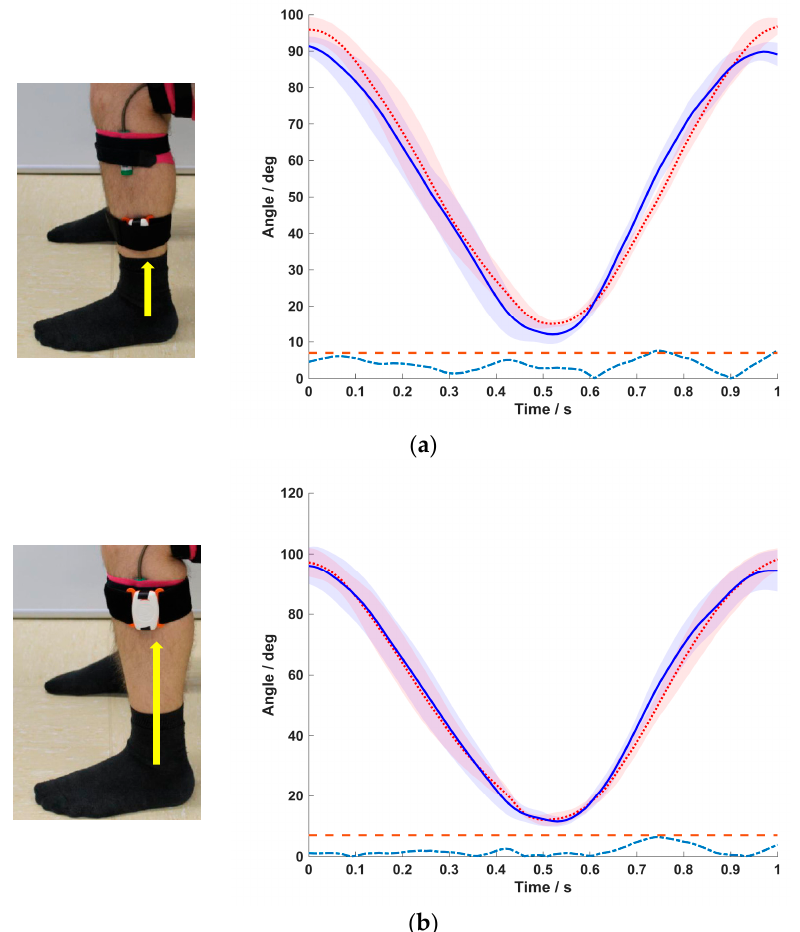
Figure 5. Mean ± SD of the five normalized movement cycles for the BPMpathway (full blue line) and the BIOPAC goniometer (dotted red line) with the di ff erence between the means (dashed turquoise line) and the 7 ◦ tolerance threshold line (dashed red line) for normal sitting position with sensor at the mid of the shank ( a ) and sensor directly under the knee ( b